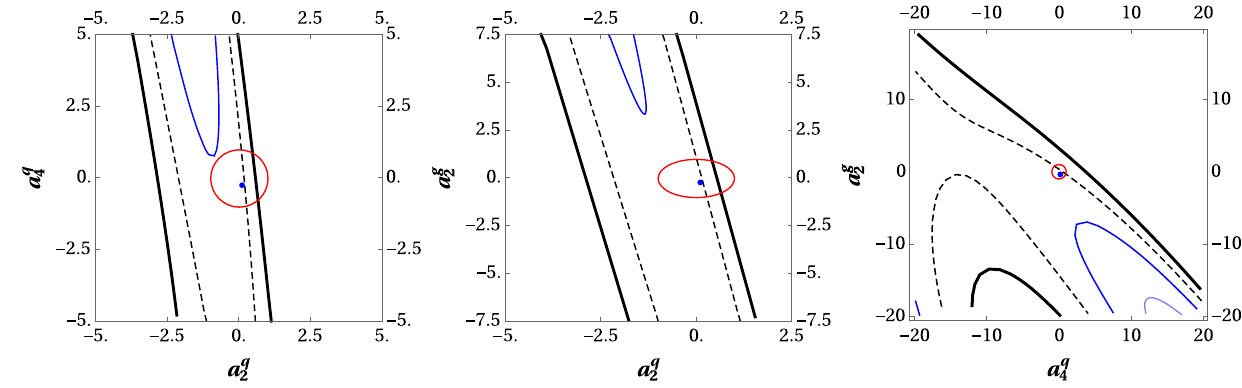
Fig. 3 The landscape of the χ 2 function evaluated for data [1] with FGC parameters in the planes of the DA moments. The dashed line corresponds to the value χ 2 / 5 = 1, the black (blue) line corresponds to χ 2 = 6 ( 4 ) . The blue dot corresponds to the values of MODEL 1. The